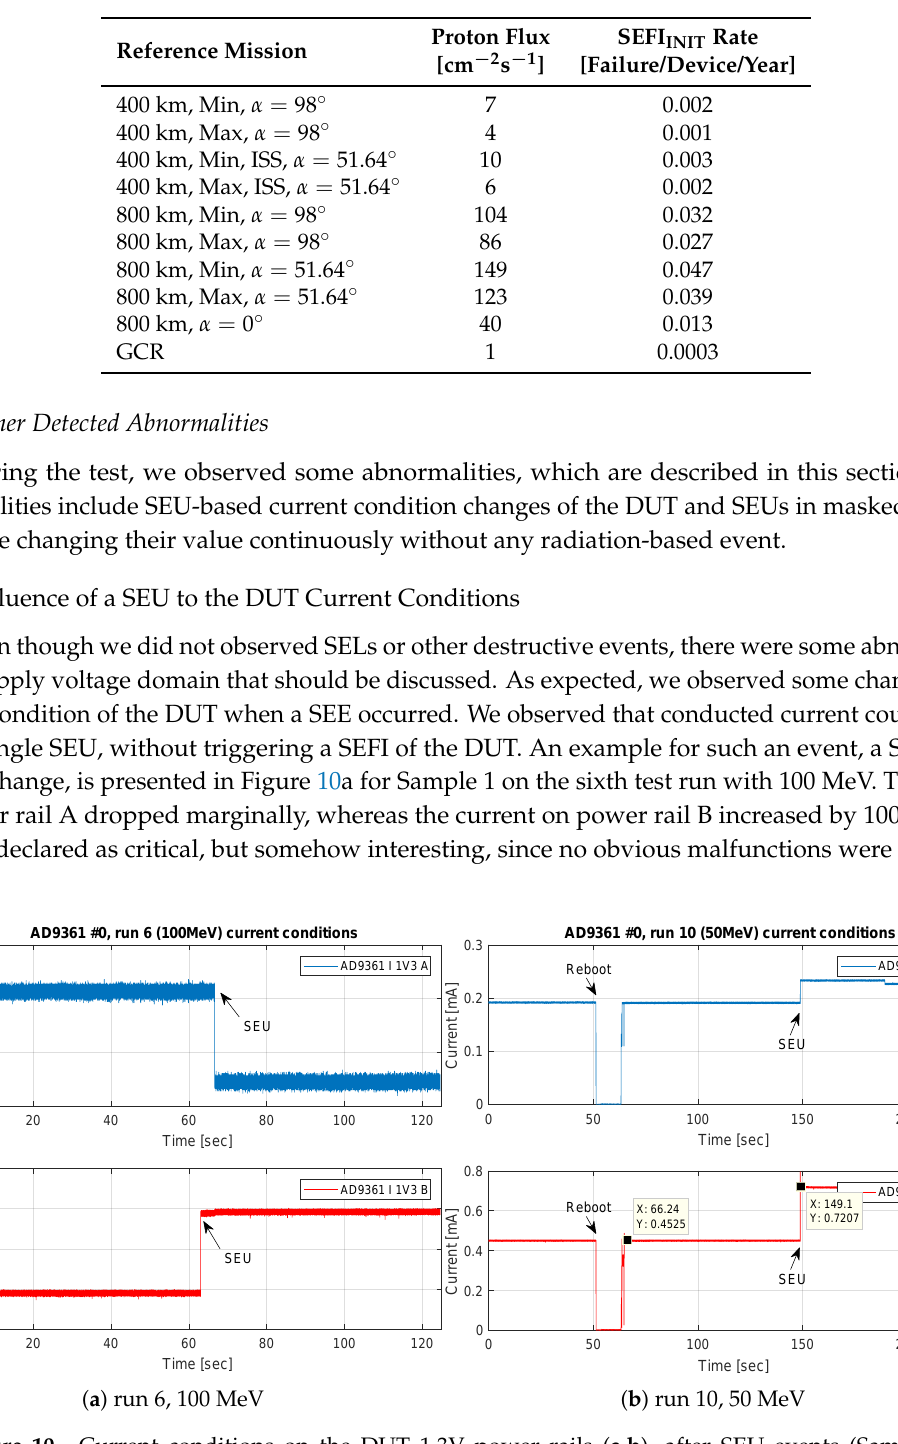
Table 15. SEFI INIT event rates for considered reference missions.